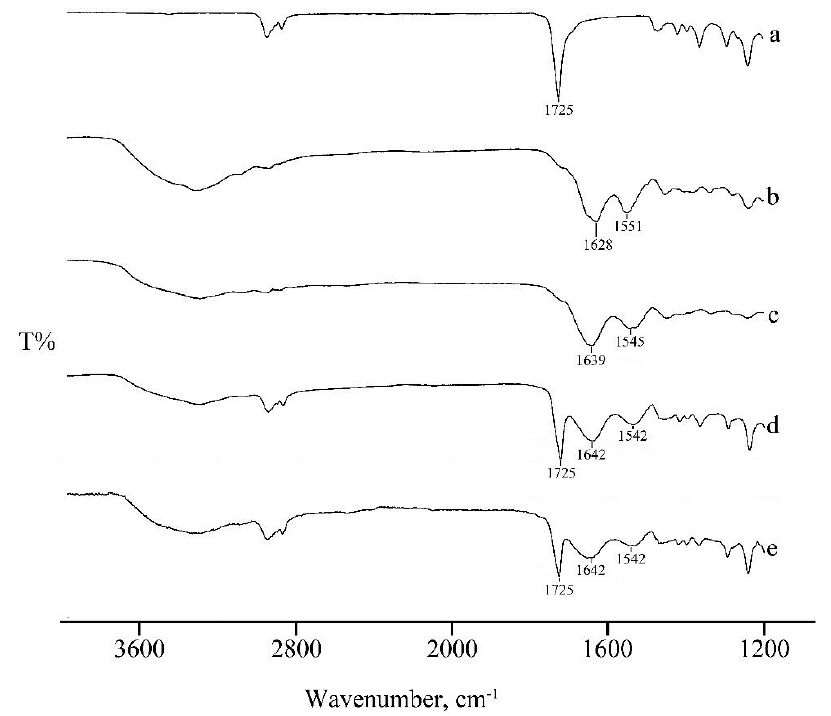
Figure 6. FTIR spectra of PCL ( a ), native collagen freeze dried ( b ) and nanofibers (NFs) based on collagen ( c ), collagen/PCL 1:1 ( d ) and 1:2 ( e ) (w/w).